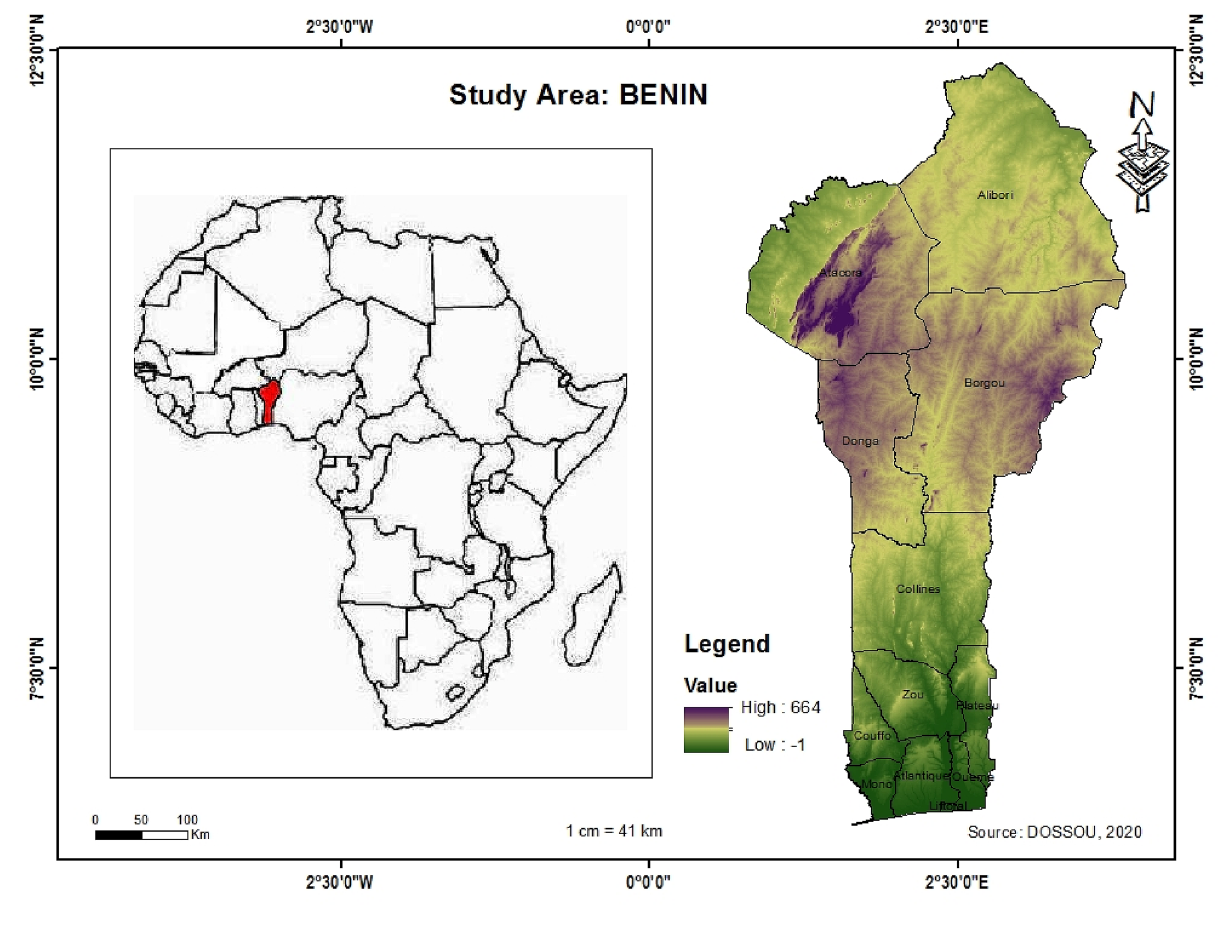
Figure 1. Location of study area.